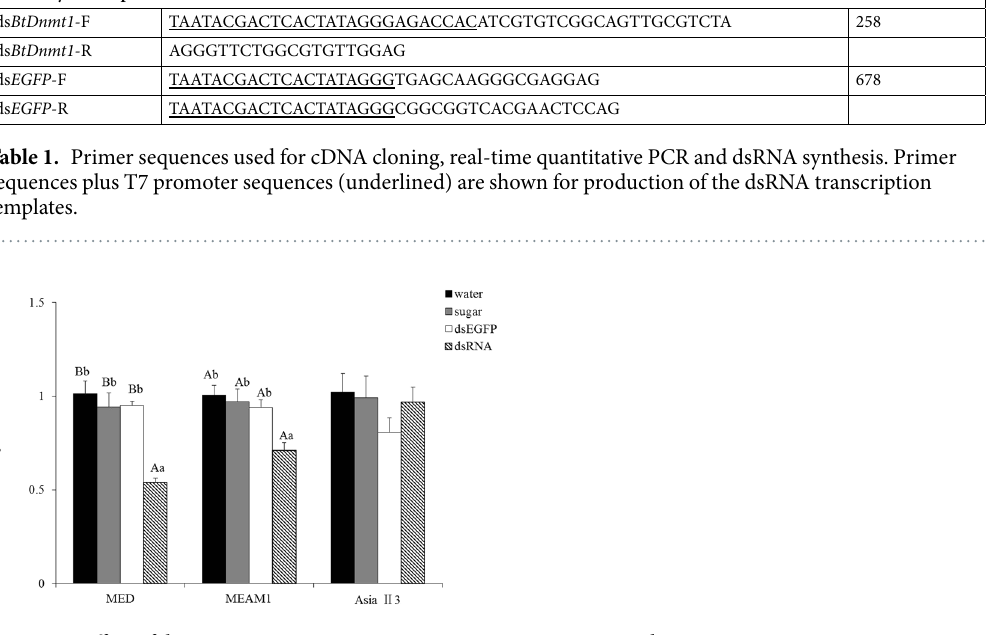
Figure 5. Effect of dsRNA treatment on Dnmt1 mRNA expression in B. tabaci . BtDnmt1 mRNA expression was significantly decreased in MED and MEAM1 after feeding with dsRNA for 3 h compared with expression in the controls. The results are expressed as the mean ± the SEM. The means with different lowercase letters above the bars are significantly different at P < 0.05. The means with different uppercase letters above the bars are significantly different at P <